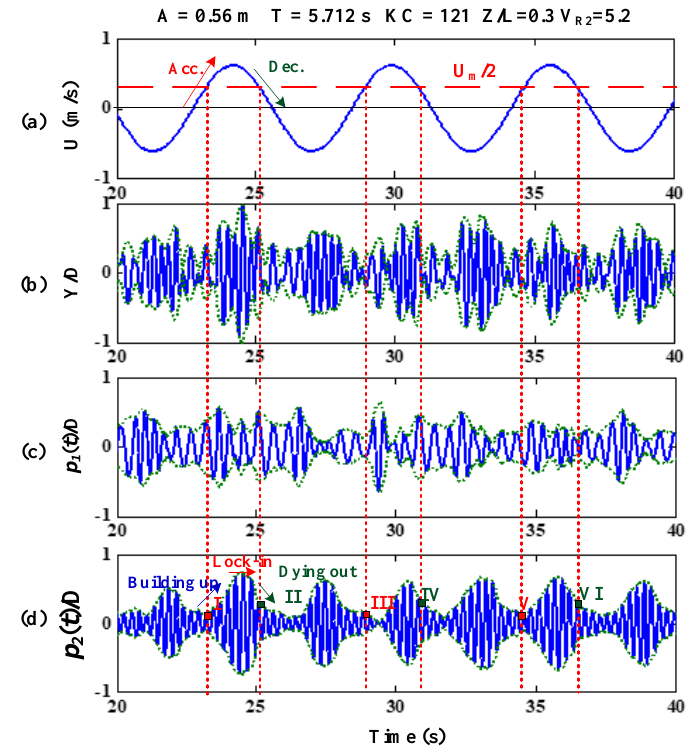
Figure 13. The time history of the VIV response and time–frequency distribution at Z / L = 0.3 for V R2 = 5.2 and KC = 121: ( a )The forced motion velocity; ( b ) The VIV displacement response; ( c ) The time–frequency distribution of VIV response; ( d ) The time-varying frequencies.